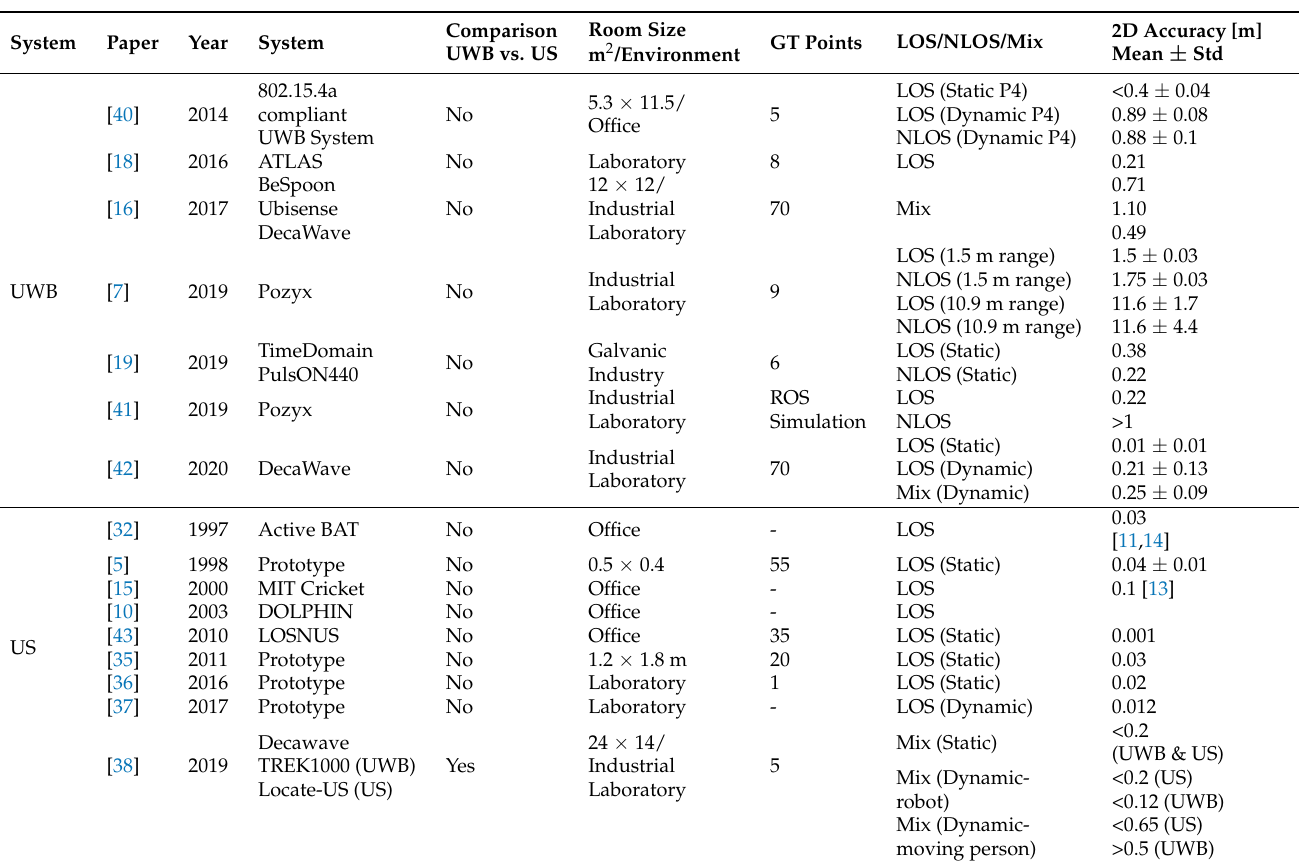
Table 1. SOTA Review and